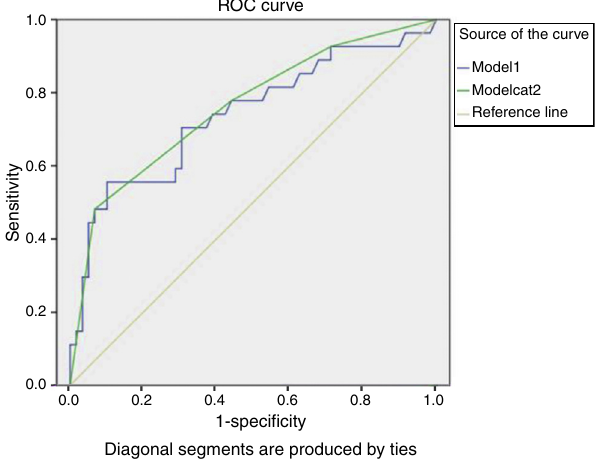
Diagonal segments are produced by ties Figure 1 Model’s area under the receiver operating charac- teristic curve. Ivory line, line of reference of AUC 0.5; blue line, score of the model; green line, four categories of the